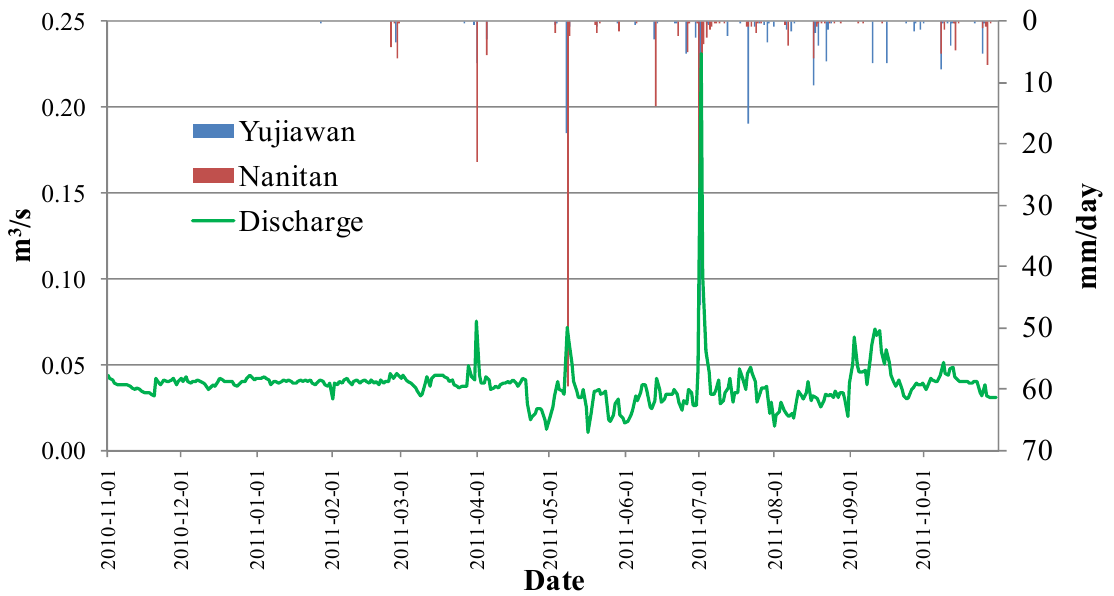
Figure 3. Rainfall at Yujiawan and Nanitan station, measured discharge at Yujiawan weir from November 2010 to October